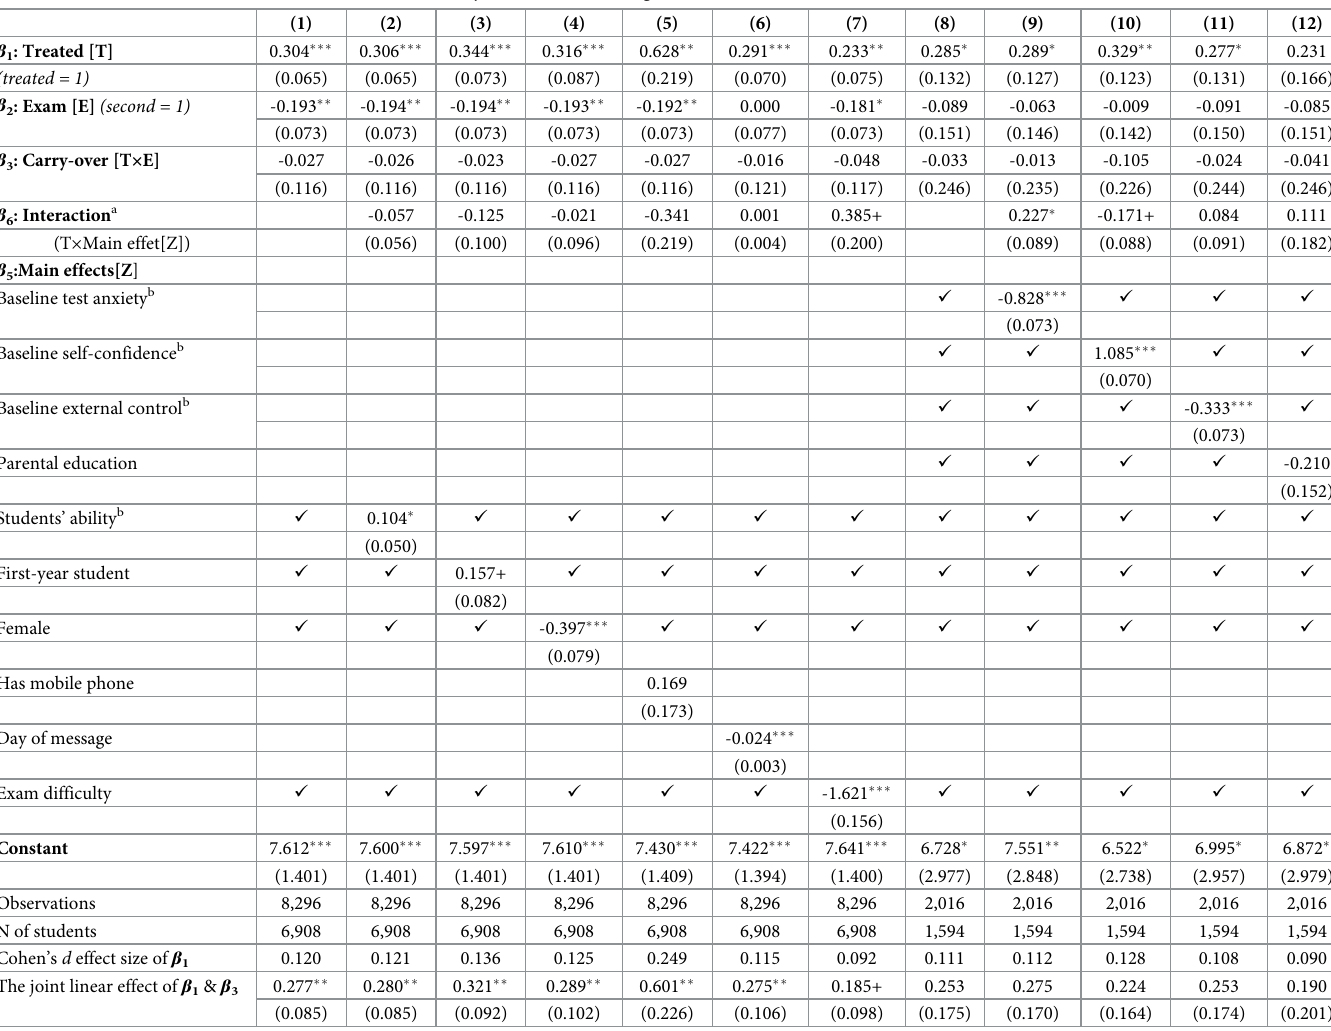
Table 3. Treatment effect on students’ endline self-efficacy, unstandardized regression